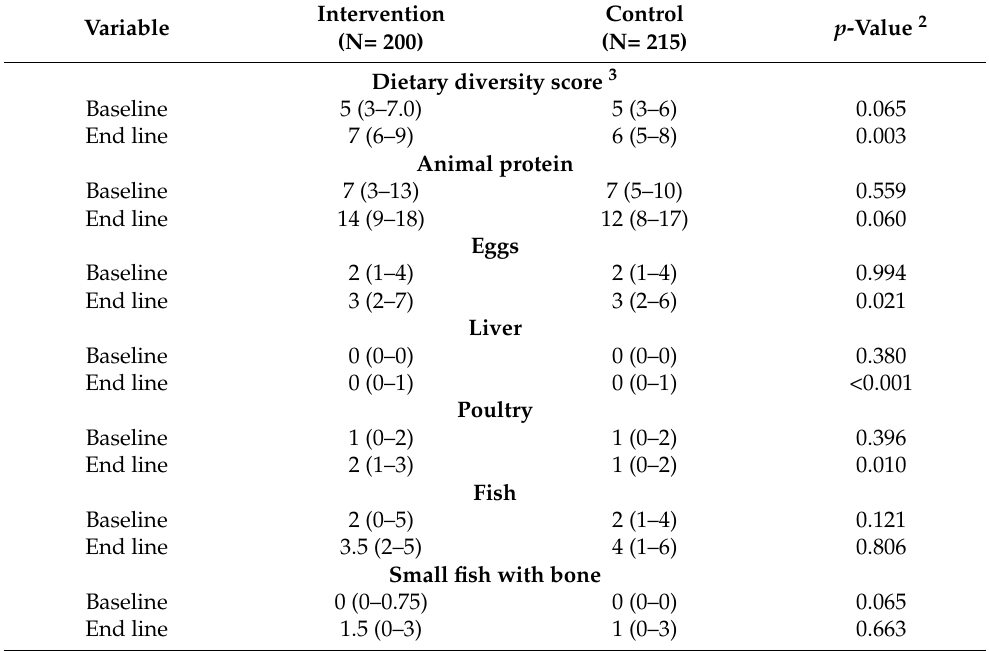
Table 2. Dietary diversity and frequency of consumption of food groups, subgroups and food items, by treatment group 1